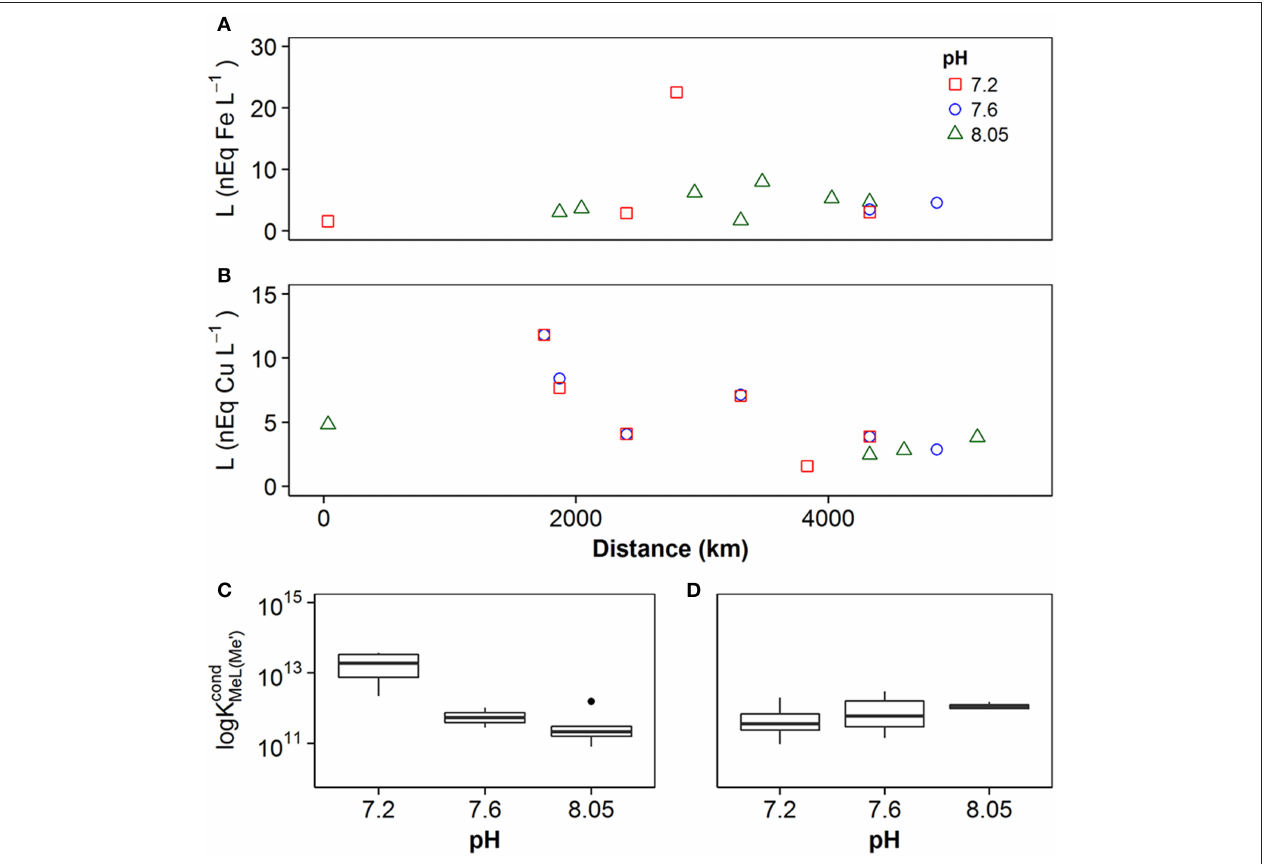
FIGURE 4 | Concentrations of ligand estimated in samples using the discrete ligand approach for (A) iron and (B) copper. Error bars represent ± 1 standard deviation from the average. (C) Box and whisker plots obtained for conditional stability constants K cond copper (D) . The box incorporates the 25th and 75th percentiles, whilst outliers are plotted as black